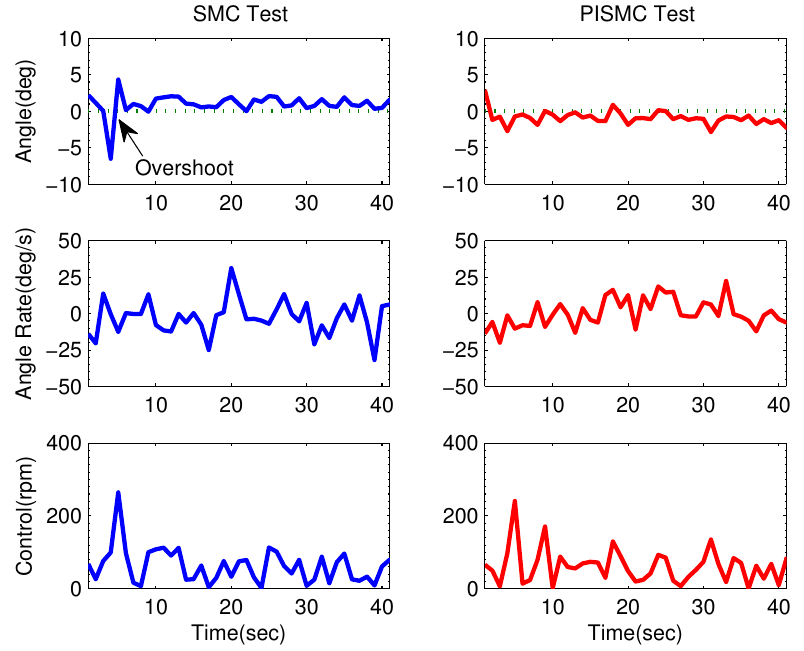
Figure 15. Experimental results of TWVS without disturbances: ( left ) SMC is implemented; ( right ) PISMC is implemented.